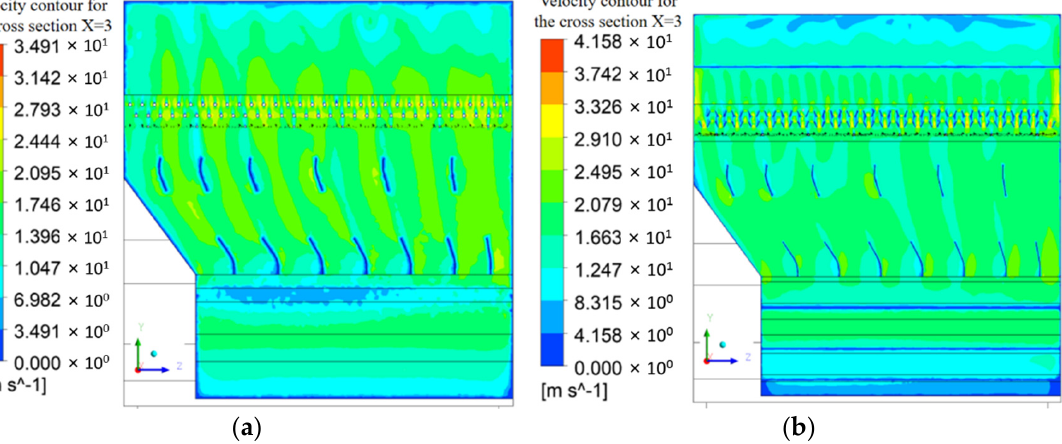
Figure 8. Contours of the flow distribution of Scheme 1 and Scheme 4.4 for the cross-section X = 3: ( a ) Scheme 1; ( b ) Scheme 4.4.